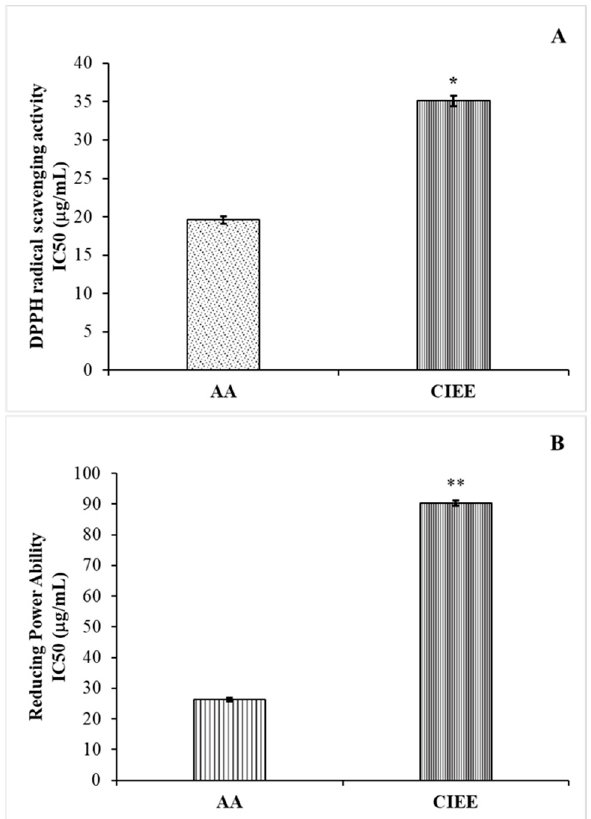
Figure 3. The antioxidant activity of C. incana ethanolic extract (CIEE), and ascorbic acid (AA) (positive control). ( A ) DPPH radical scavenging activity; ( B ) reducing power ability. Data are presented as the mean (IC 50 µ g/mL) ± SD of a triplicate measurement. * p < 0.05, ** p < 0.01.